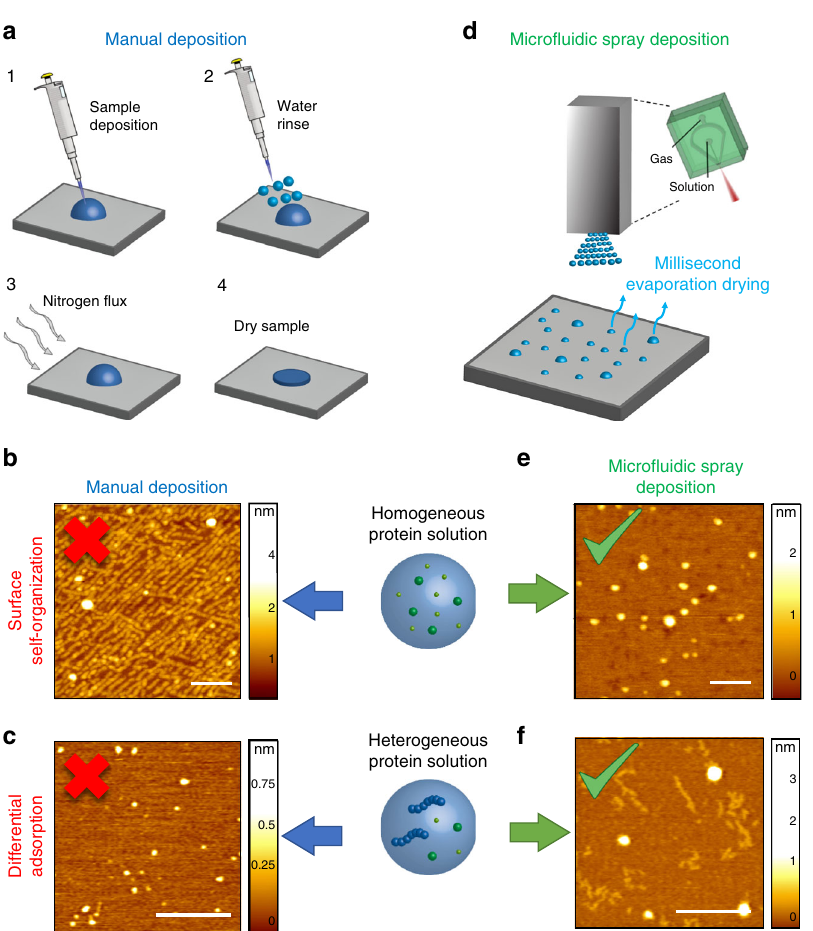
Fig. 1 Manual vs. single-step deposition by micro fl uidic spray device. AFM sample preparation by ( a ) conventional manual deposition. This method may cause the ( b ) self-organization of monomeric α -synuclein along the crystallographic lattice of the mica substrate (scale bar 100 nm). c Furthermore, manual deposition typically enables only a partial depiction of a heterogeneous A β 42 aggregated solution on a mica surface because of differential adsorption (scale bar 100 nm). While, (d) single-step micro fl uidic spray deposition ( e ) conserves the molecular architecture and assembly state of proteins in solution, and ( f ) enables to unravel the full content of the multiple protein species in solution (scale bars 200